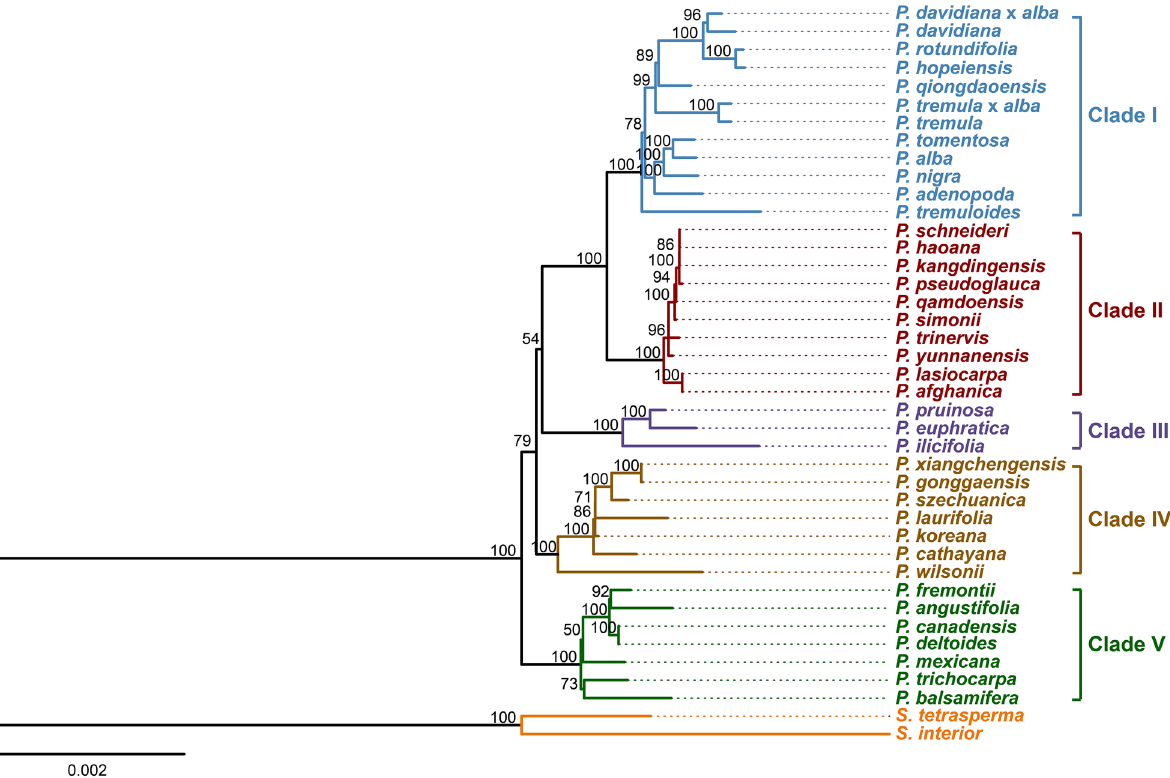
Figure 2. Phylogenic tree of 39 Populus species based on an alignment of 76 chloroplast coding genes using the ML method. Two Salix species were used as out-groups. The number above each node indicates the BS support value for that